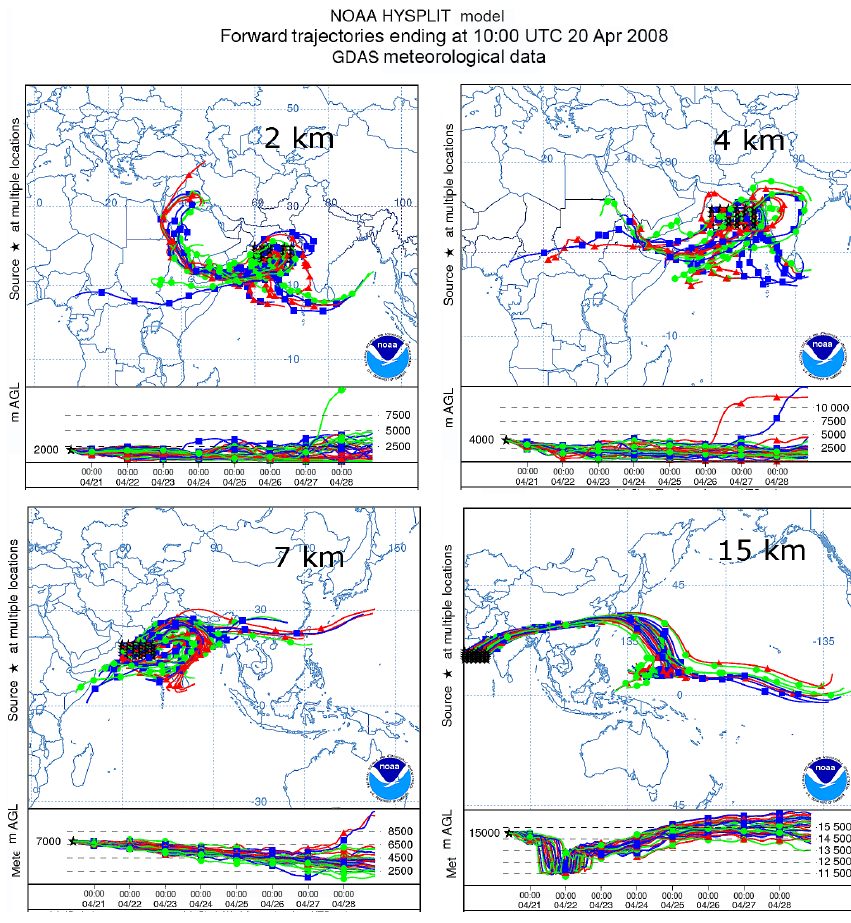
Figure 7. HYSPLIT trajectory 240h forward model results for air masses at AS with source location at 2, 4, 7 and 15km.